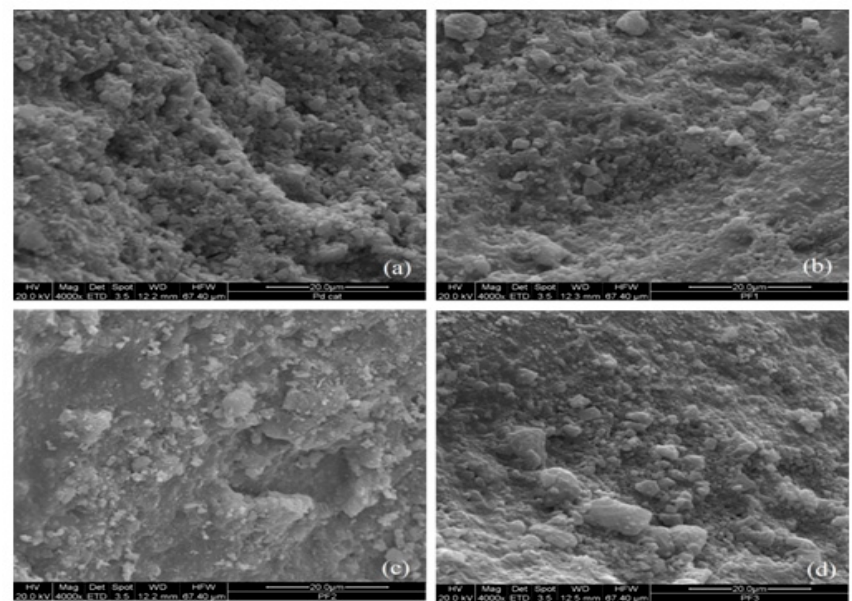
Figure 2. Scanning Electron Microscope (SEM) images of ( a ) Pd, ( b ) PF1, ( c ) PF2, and ( d ) PF3 catalysts (×4000 Magnification).